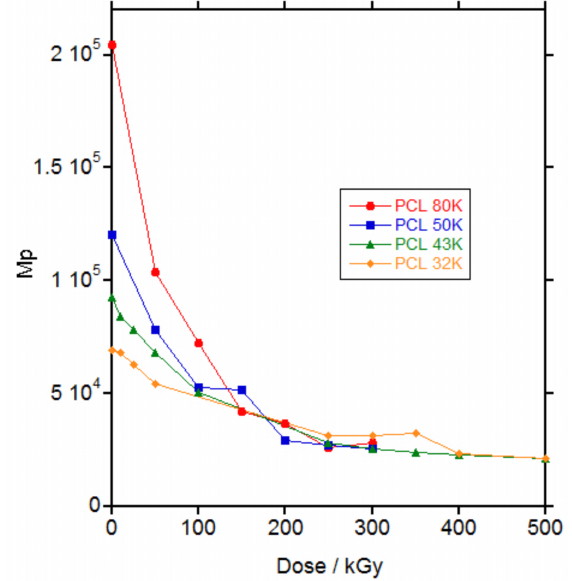
Figure 3. Molecular weight on the maximum of the size exclusion chromatography (SEC) curve ( M p ) vs. dose for the irradiated PCLs. The molecular weight corresponds to the whole sample at doses below gelation (below 100 kGy for PCL 80 K and below 150 kGy for PCL 50 K, PCL 43 K and PCL 32 K) and to the soluble part of the sample above